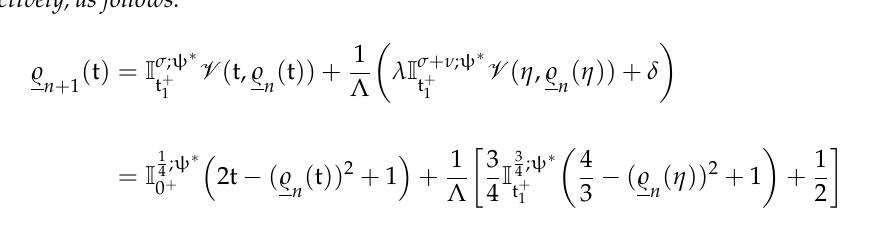
Table 2. Numerical results of (cid:36)